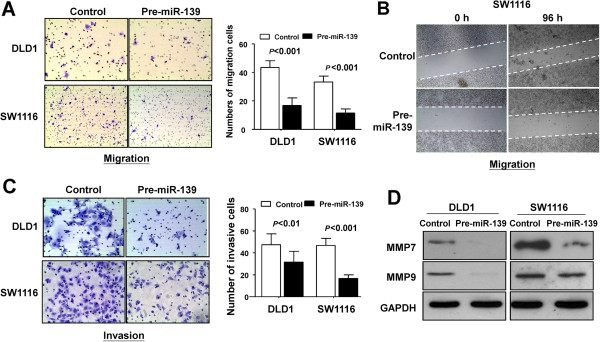
miR-139-5p inhibited colon cancer cell migration and invasion. (A) Re-expression of miR-139-5p in DLD1 and SW1116 cells significantly inhibited cell migration ability as determined by cell migration assay (left panel) Quantitative analysis of migrated cell in DLD1 and SW1116. The data are means ± SD. (B) The inhibition on cell migration by miR-139-5p was further confirmed by wound-healing assay. (C) Re-expression of miR-139-5p in DLD1 and SW1116 cells significantly suppressed cell invasive ability as determined by cell invasion assay. (D) miR-139-5p significantly downregulated MMP7 and MMP9 protein levels in both colon cancer cell lines.